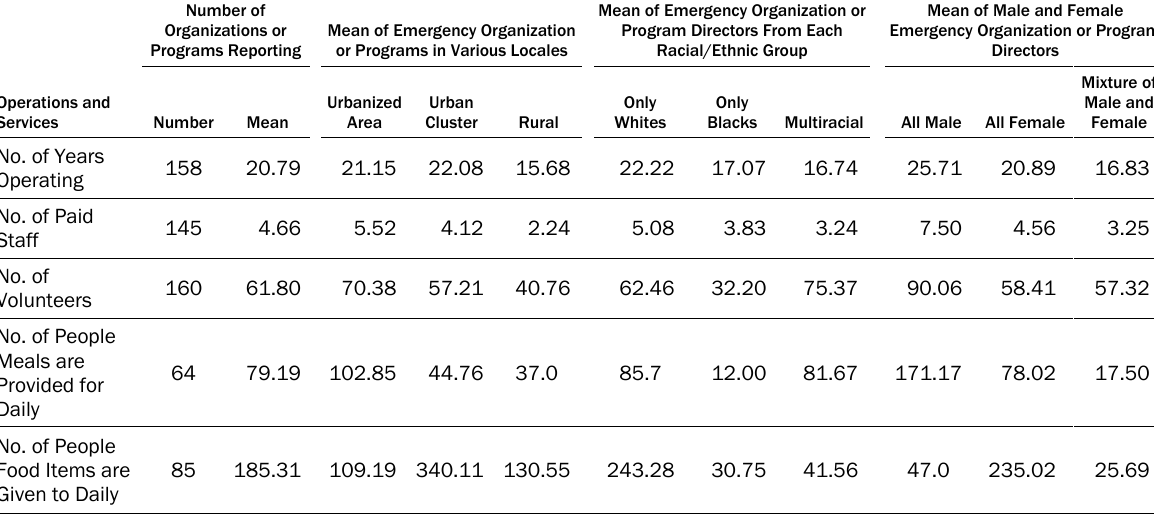
Table 4. Means Comparisons of Emergency Food Assistance Organizations and Programs